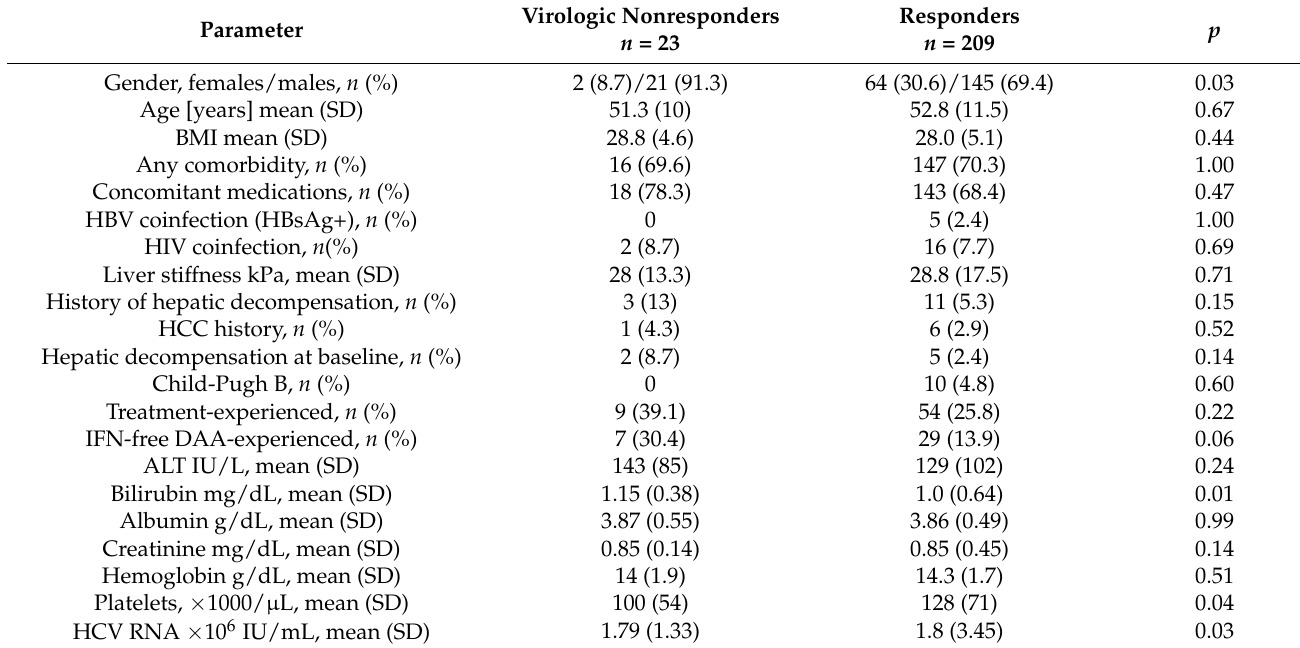
Table 6. Virologic nonresponders vs. responders to pangenotypic